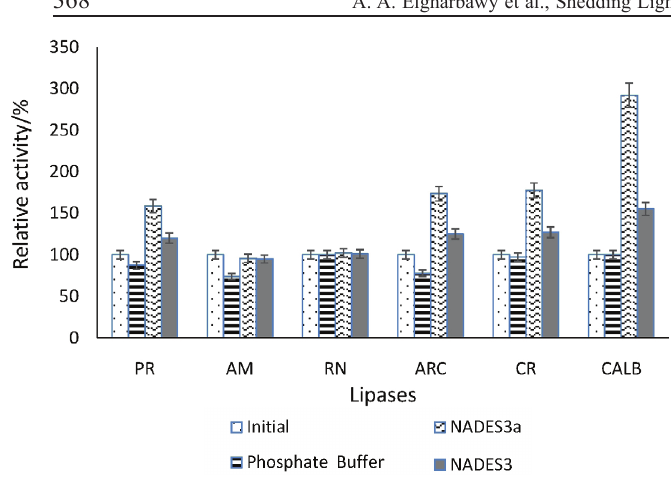
Fig. 6 – Relative activity of lipases after storage in NADES3, NADES3a and buffer compared to the initial activity for 72 hours at 4.0±2.0 °C. Lipase from porcine pancreas (PR), lipase from Candida rugosa (CR), Amano lipase PS, from Burkholde- ria cepacia (AM), lipase from Rhizopus niveus (RN), lipase acrylic resin from Candida antartica (ARC) (recombinant, ex- pressed in Aspergillus niger), Lipase B Candida antartica im- mobilized on Immobead 150, recombinant from Aspergillus oryzae